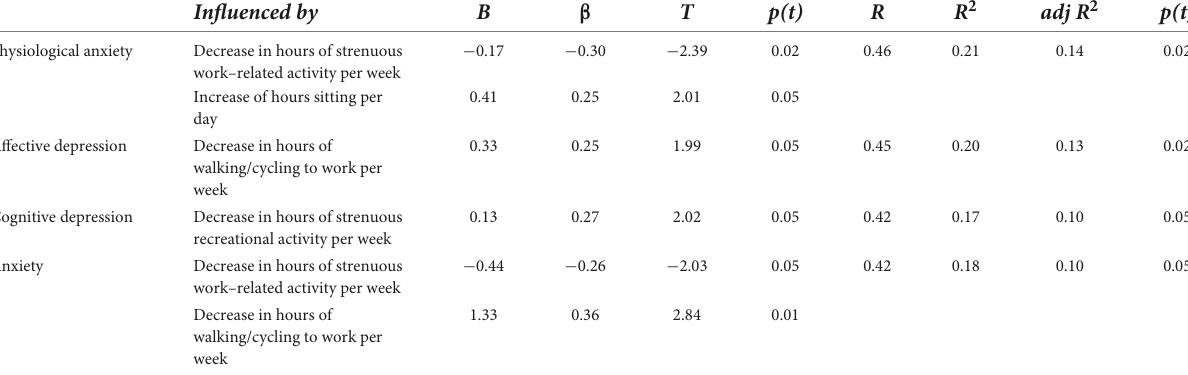
TABLE 4 Prediction of anxiety and depression based on changes in amount of physical activity (PA) due to epidemic for male participants. Influenced by B β T p(t) − 0.17 Decrease in hours of strenuous work–related activity per week